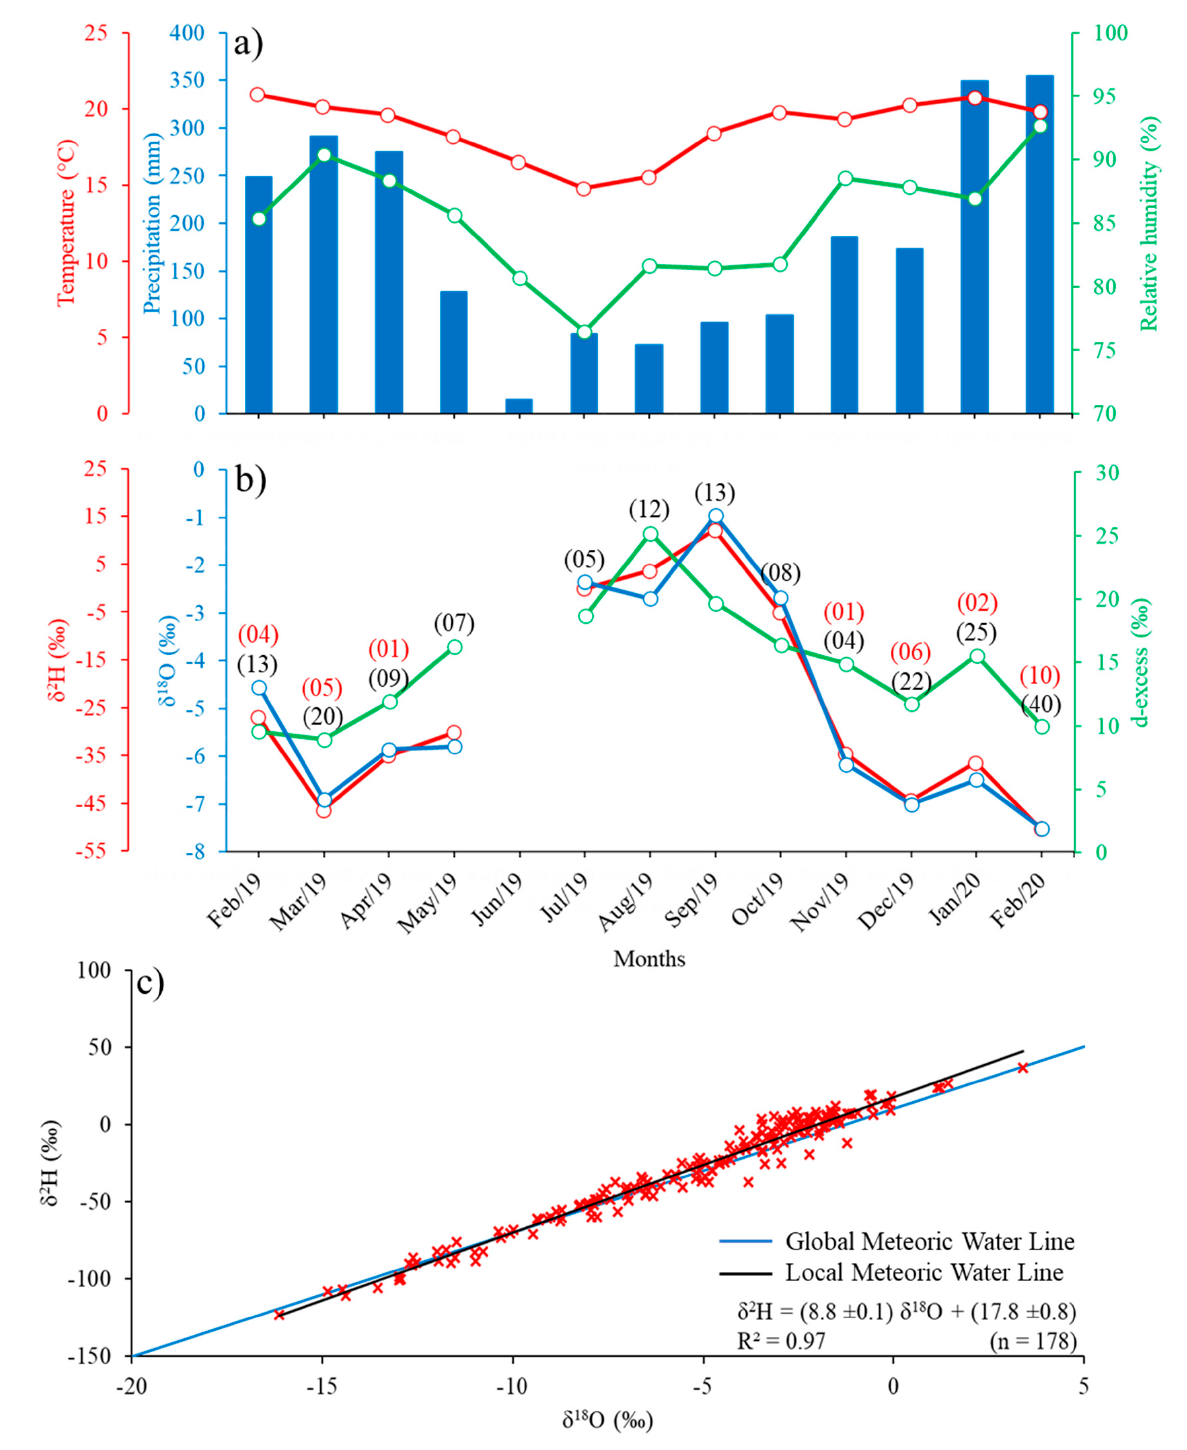
Figure 2. Temporal variability of meteorological and isotopic variables in S ã o Francisco Xavier, Brazil. ( a ) Monthly amount of precipitation (blue bars), monthly average air temperature (red line), and monthly average of relative humidity (green line). ( b ) Weighted average rainfall of δ 18 O (blue line), δ 2 H (red line), and d-excess (green line). Values in black parentheses represent the total number of collections in each month, and in red parentheses represent the number of collections during SACZ events. ( c ) Global Meteoric Water Line (GMWL) and Local Meteoric Water Line (LMWL).